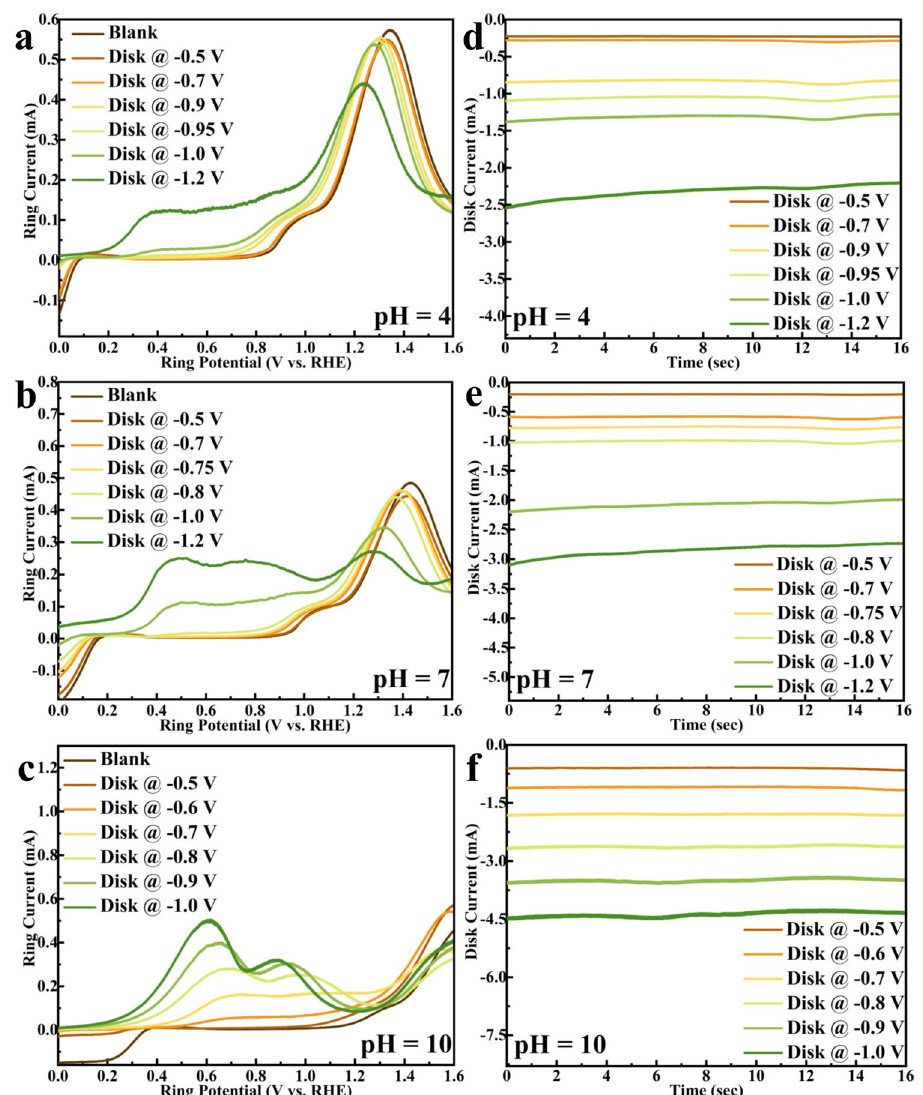
Fig. 1 | Rapid product detection by rotating ring-disk electrode (RRDE) during acetaldehyde reduction on Cu. a – c Cyclic voltammograms (CVs) of products detected by the Pt ring electrode during Cu catalyzed acetaldehyde reduction atpH = 4(0.0001M HClO 4 + 0.0999 MNaClO 4 ), 7 (0.1 M NaClO 4 ),10 (0.0001 M NaOH + 0.0999 M NaClO 4 ), respectively. Only the